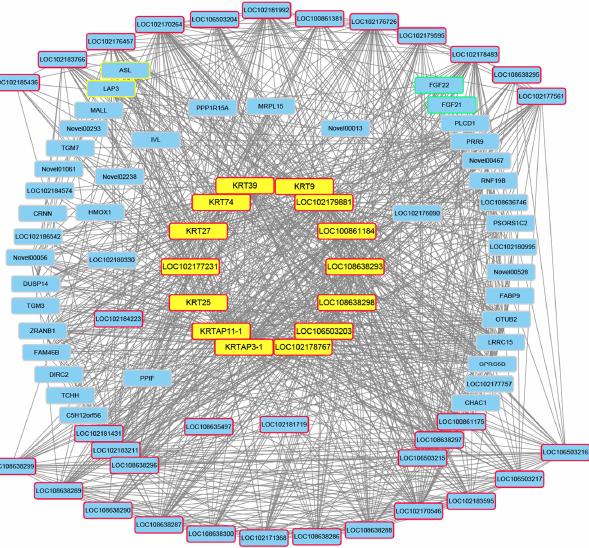
Figure 5. Gene coexpression network in the magenta module. The genes framed in red are the genes of the intermediate filaments (GO:0005882), the genes framed in yellow are arginine and proline metabolism (chx00330), the genes framed in green are the MAPK signaling pathway (chx04010), and the genes with a yellow background are the candidate genes.